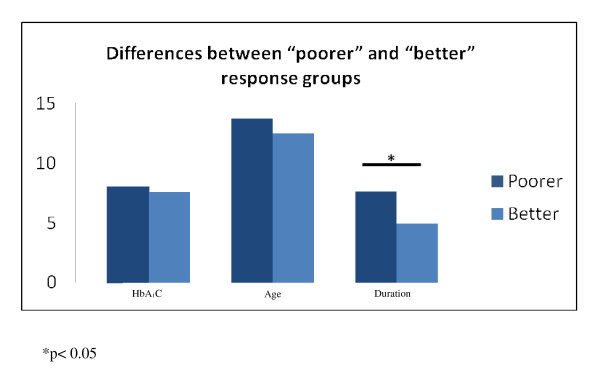
Combined group comparison for age, diabetes duration and HbA1C.